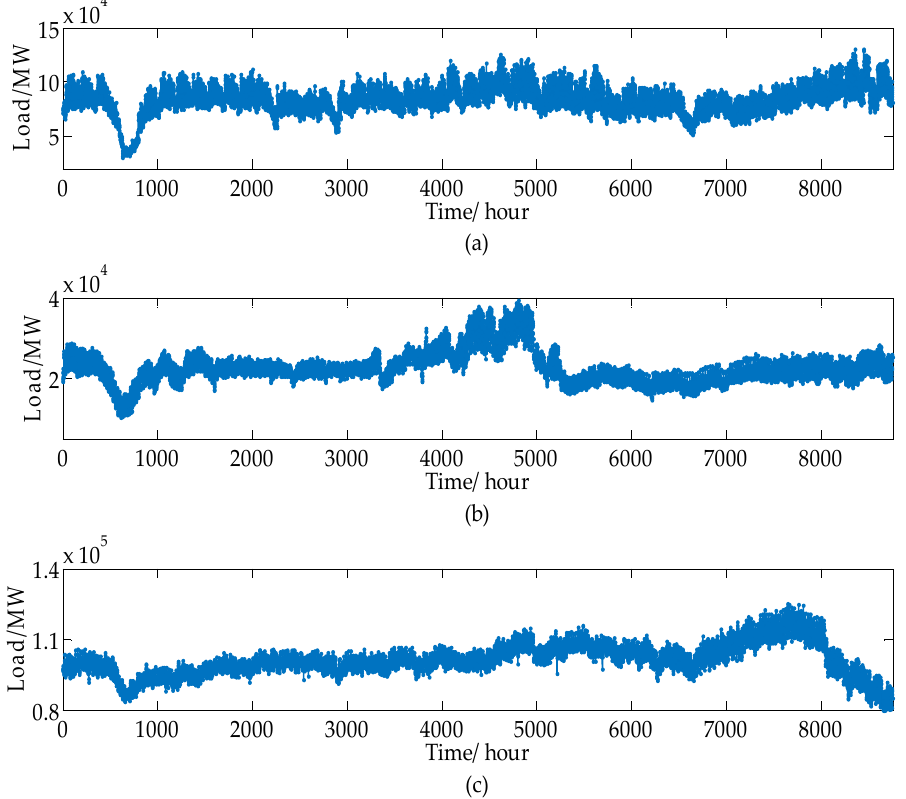
Figure 3. ( a ) Industrial city, ( b ) small-scale city, and ( c ) medium-sized city. The first load fluctuation